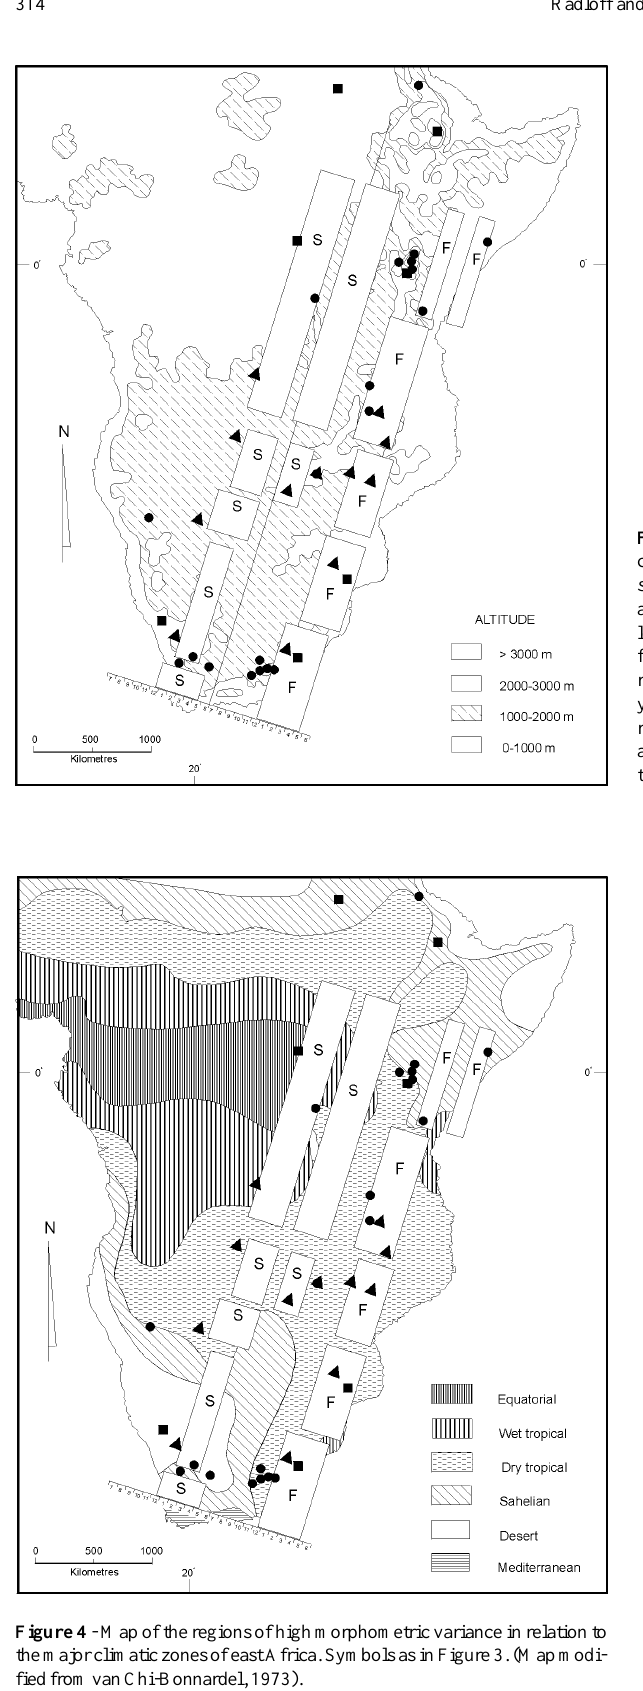
Figure 4 - Map of the regions of high morphometric variance in relation to the major climatic zones of east Africa. Symbols as in Figure 3. (Map modi- fied from van Chi-Bonnardel,